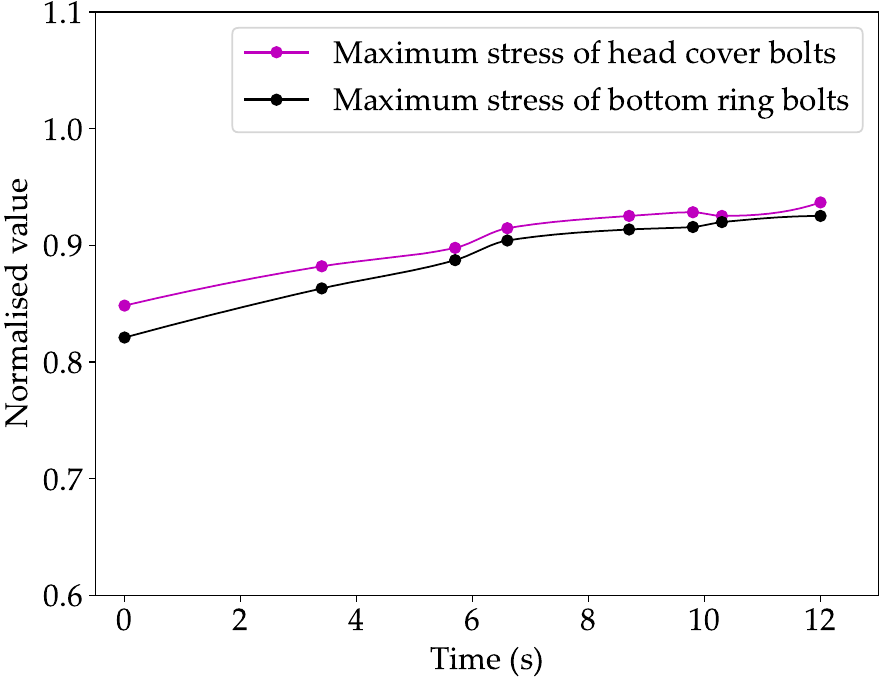
Figure 13. The maximum stress of the connecting bolts at different moments during load